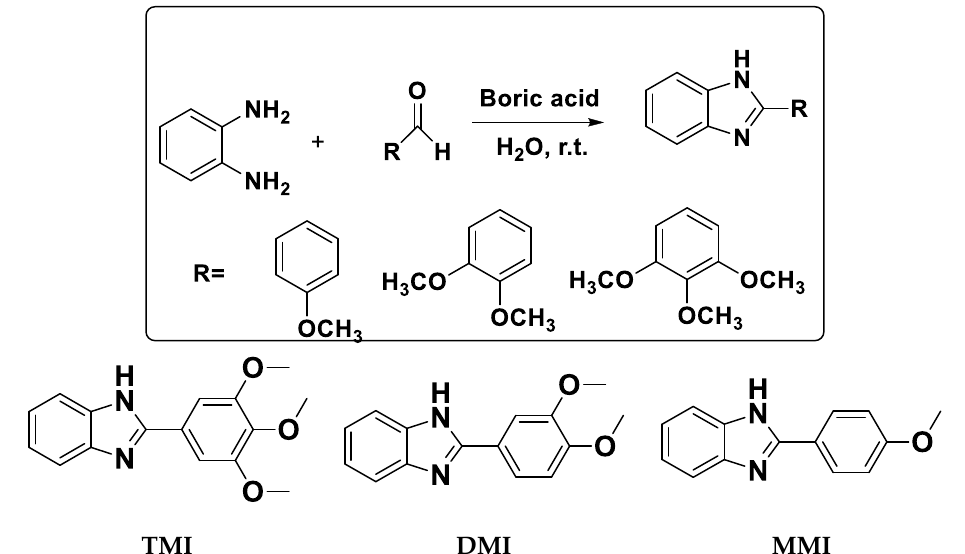
Figure 1. Synthetic scheme and molecular structure of the benzimidazole derivatives. 2-(3,4,5- Trimethoxyphenyl)-1 H -benzo[ d ] imidazole (TMI); 2-(3,4-Dimethoxyphenyl)-1 H -benzo[ d ] imidazole (DMI); and 2-(4-Methoxyphenyl)-1 H -benzo[ d ] imidazole (MMI).